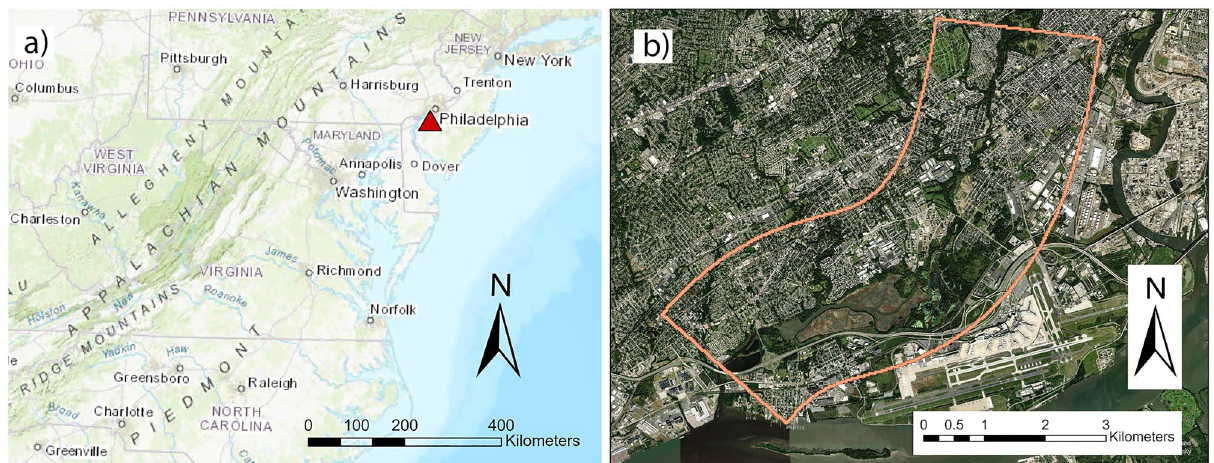
Figure 1. The figure above shows the global ( a ) and local ( b ) terrain of the study area. Maps are processed and generated in the ArcGIS Pro platform 81